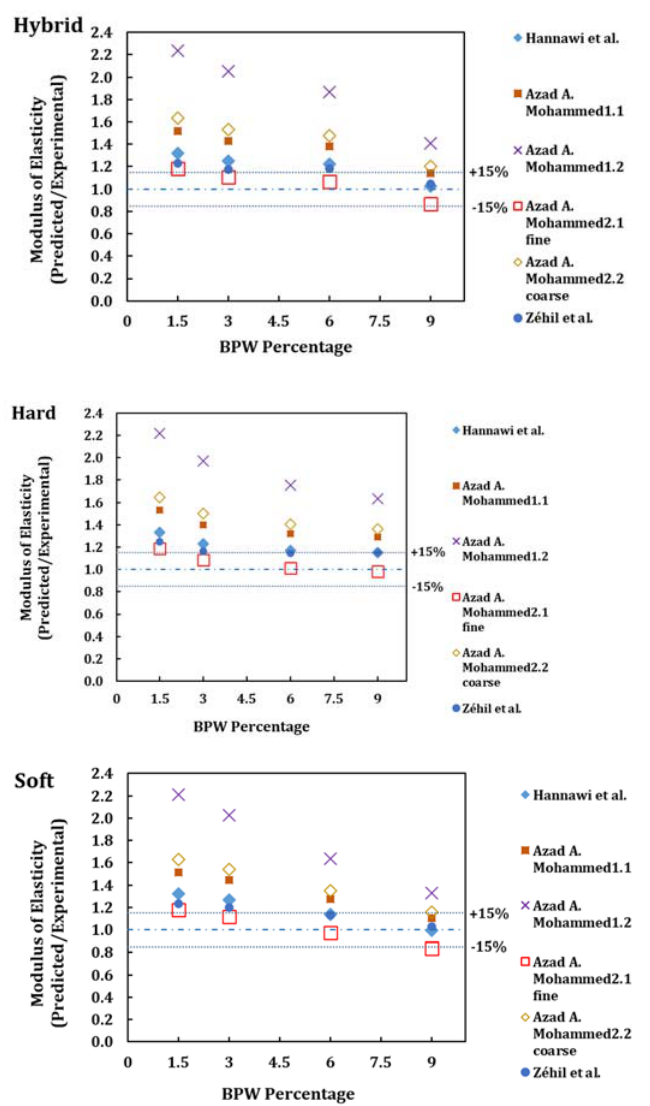
Figure 19. The ratio of predicted modulus of elasticity by the introduced formulae of other studies for BPW-containing concrete, and experimental results [39,42,50,51].